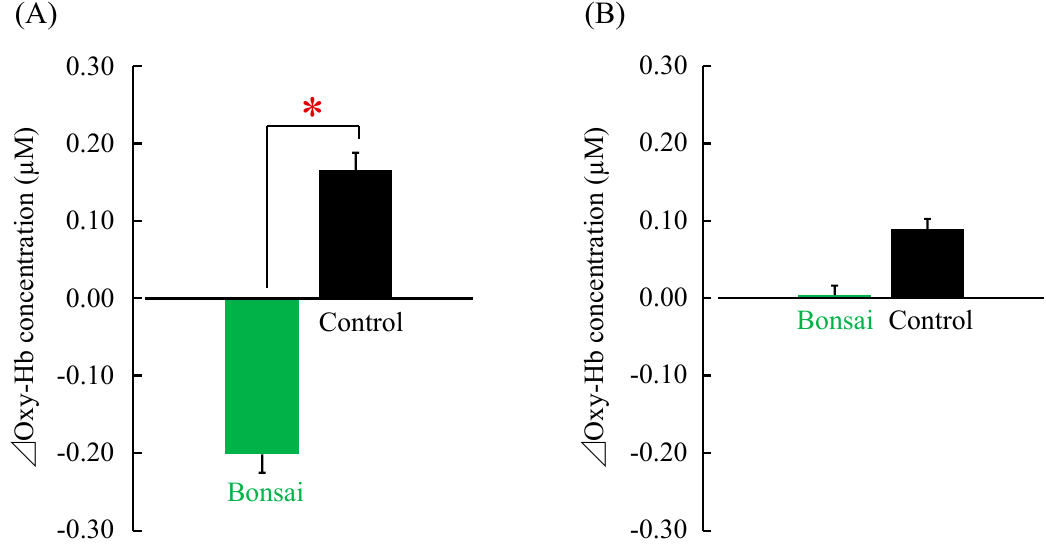
Figure 2. Mean oxy-Hb concentrations in the prefrontal cortices. ( A ) Changes in the left prefrontal cortex when viewing bonsai trees vs. control; ( B ) Changes in the right prefrontal cortex. N = 24, mean ± standard error. * p < 0.05, paired t -test. ∆ , change.